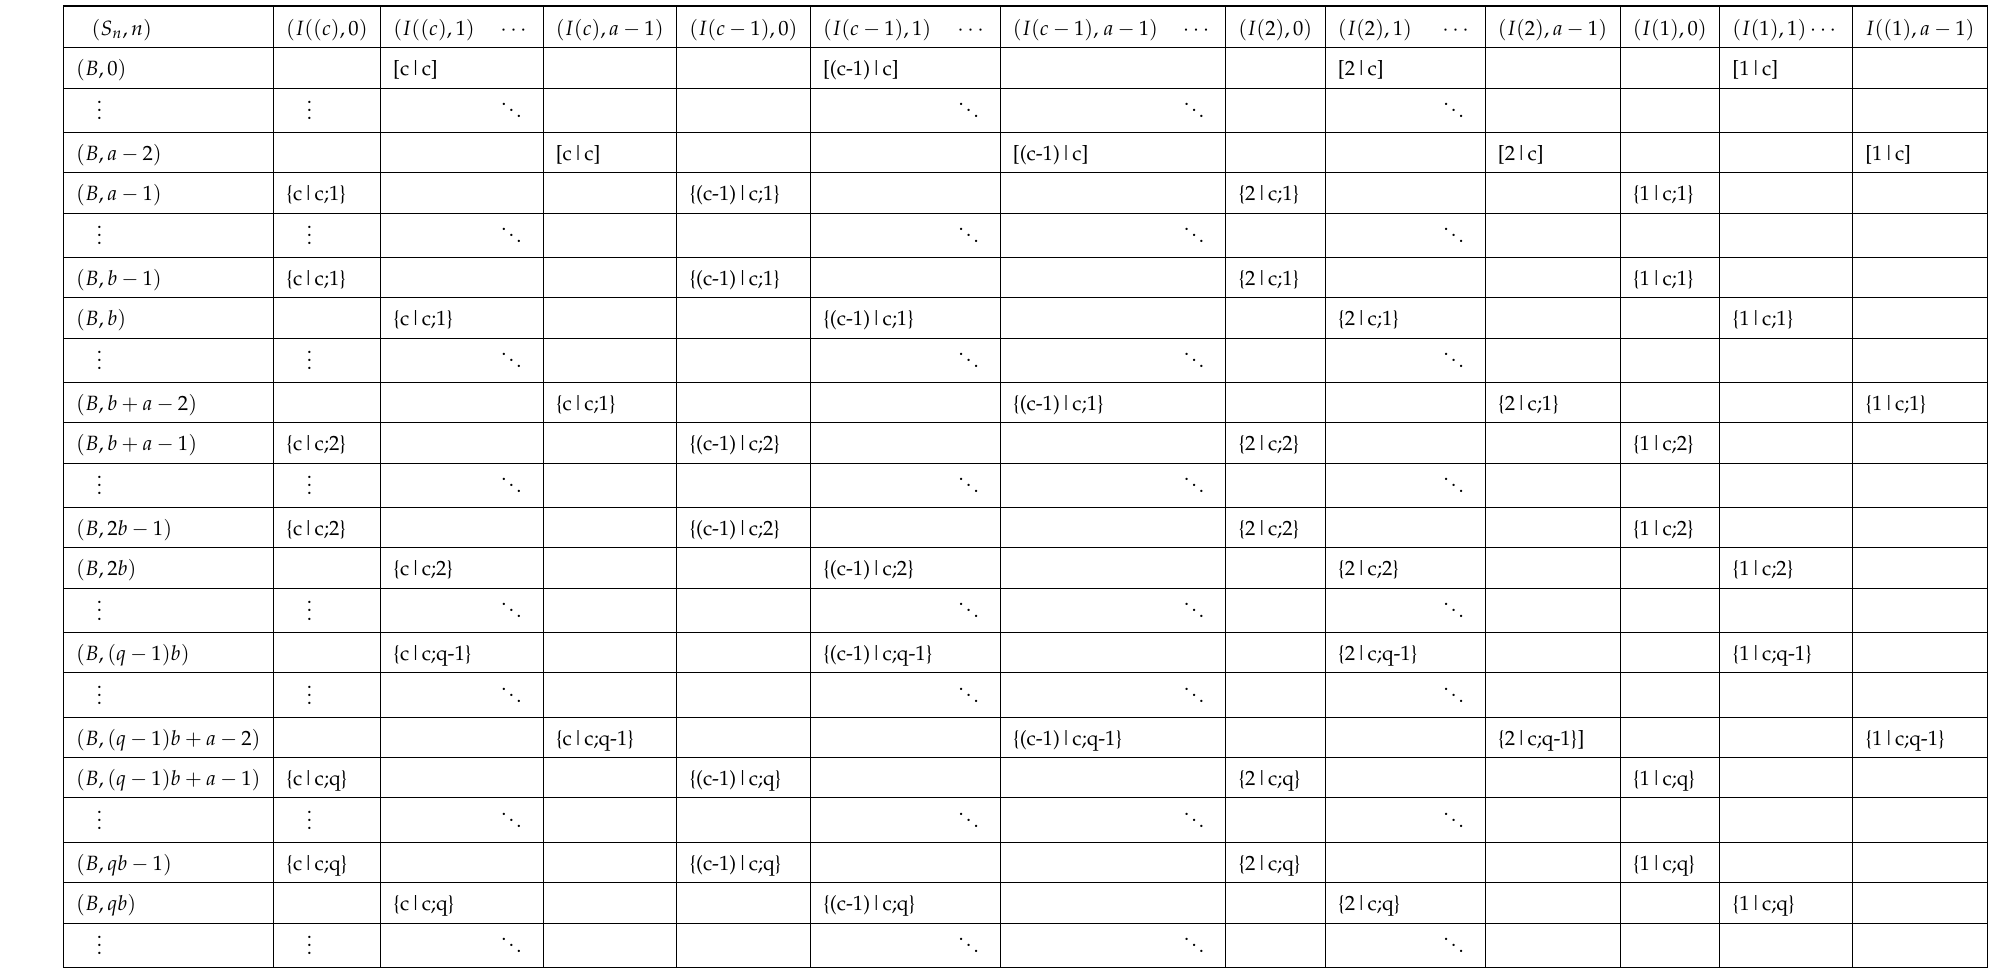
Table 2. Submatrix T Busy → Idle